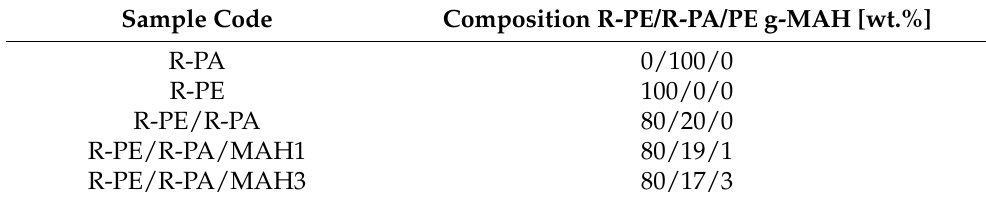
Table 1. Sample codes and polymer blend